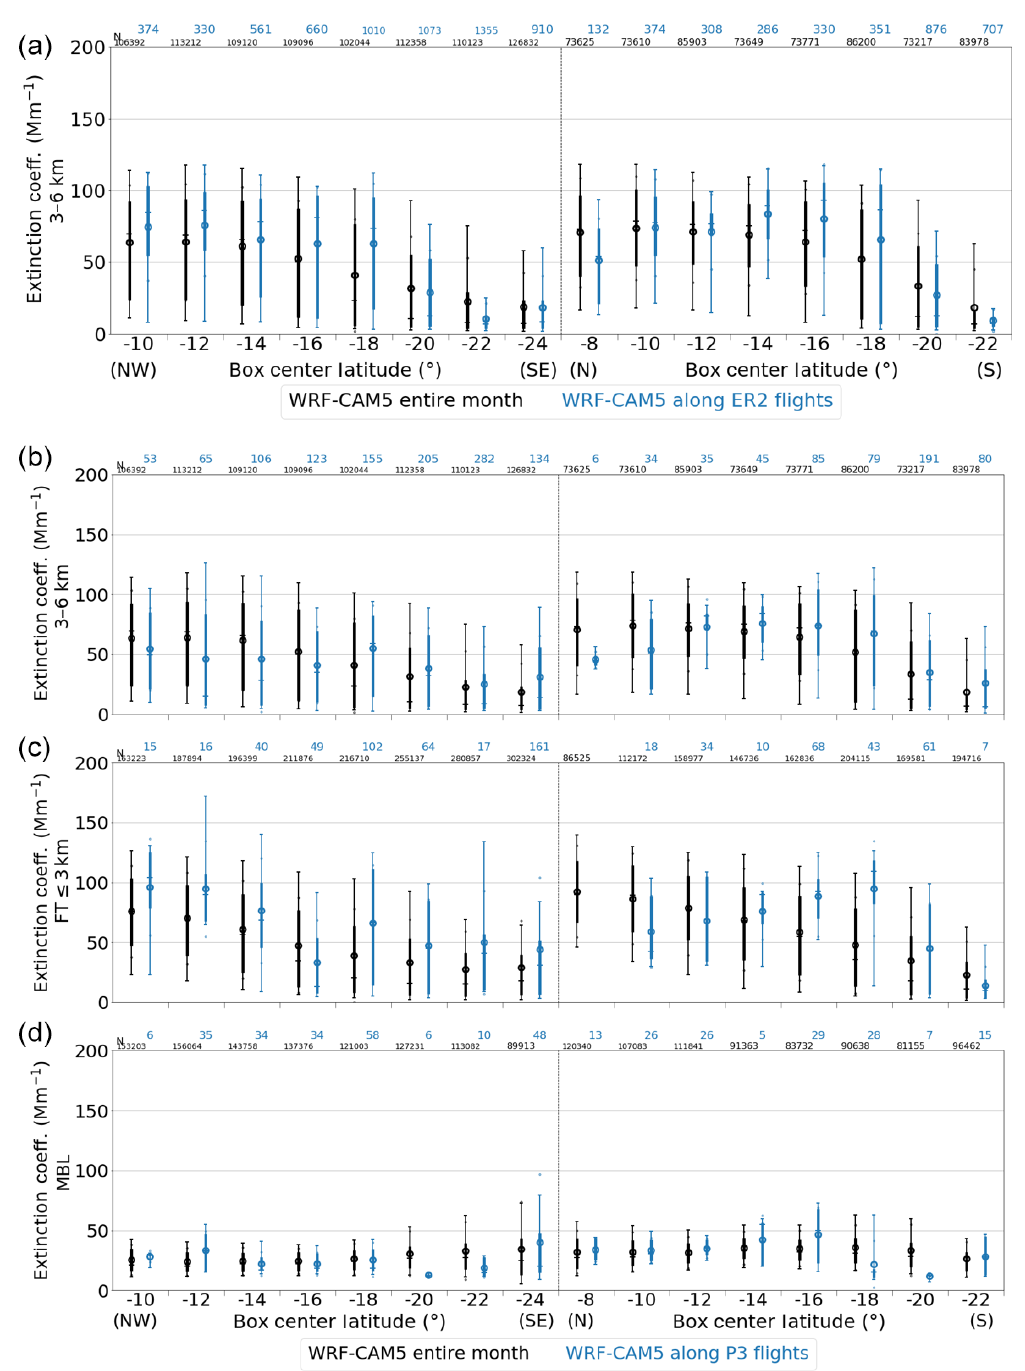
Figure 4. Extinction coefficients compared between two extracts (monthly climatology and flights) of WRF-CAM5 simulations. Panel (a) is along the ER2 tracks for altitudes between 3 and 6km. The other three panels are for the P3 tracks for 3–6km (b) , the top of MBL to 3km (c) , and the MBL (d) . In each panel, the abscissa represents the eight diagonally aligned boxes and eight meridionally aligned boxes described in Sect. 3.2 and Fig. 2. In each box, the bars indicate the monthly climatology (black) and samples along the flights (blue). Distributions are represented as box-and-whisker plots encompassing the 10, 25, 50, 75, and 90th percentiles, with circles indicating the mean and mean ± standard deviation values. The numbers in small print at the top of each panel indicate the number of samples.